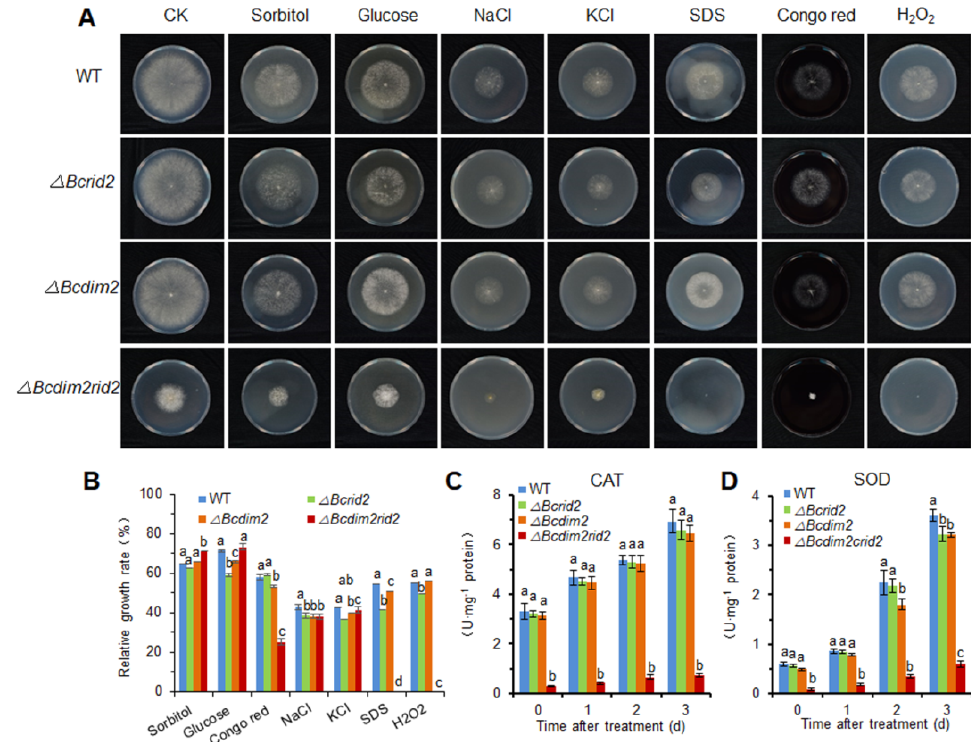
Figure 6. The oxidative tolerance of ∆ Bcdim2rid2 is significantly decreased. ( A ) Tolerance test of wild-type and mutants to osmotic stress (1 M sorbitol, 1 M glucose, 1 M NaCl, and 1 M KCl), cell wall stress (2 mg/mL Congo red, 0.02% SDS), and oxidative stress (10 mm H 2 O 2 ). ( B ) Relative growth rates of wild-type and mutants under different stressors. ( C ) The activities of catalase (CAT) in wild-type and mutants. ( D ) The activities of superoxide dismutase (SOD) in wild-type and mutants. Vertical bars represent standard errors of the means. Columns with different letters indicate significant differences ( p < 0.05).